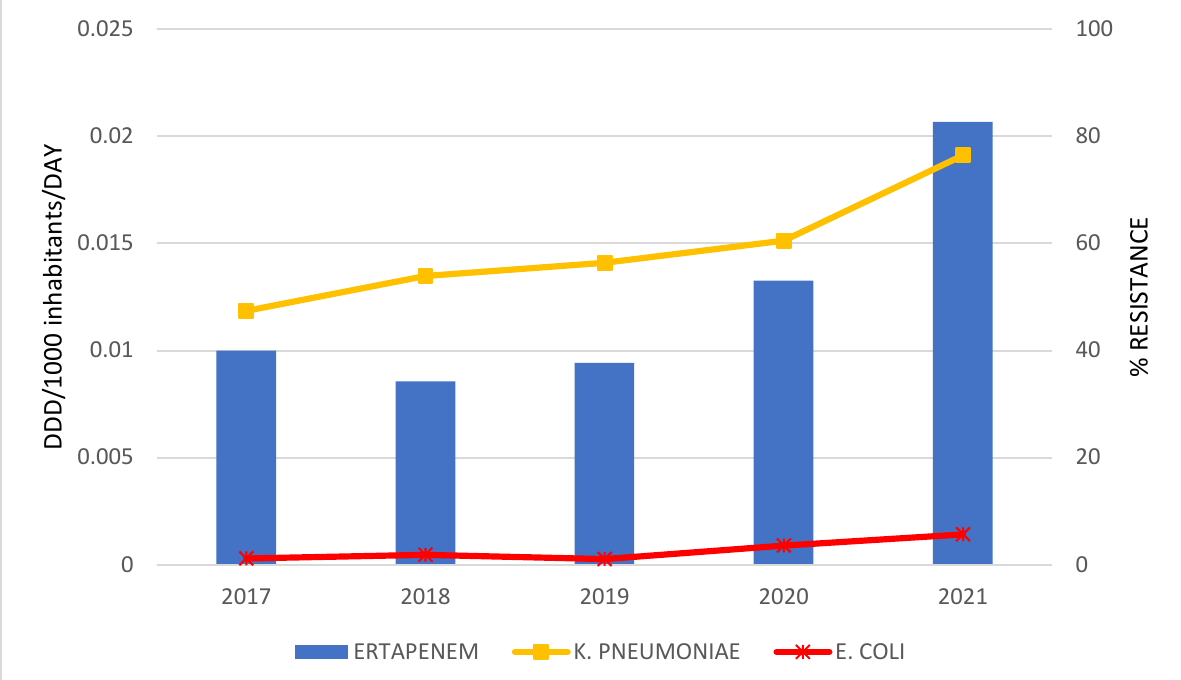
Figure 3. The correlation of ceftriaxone consumption and the resistance to ceftriaxone in bacteria during 2017 – 2021.